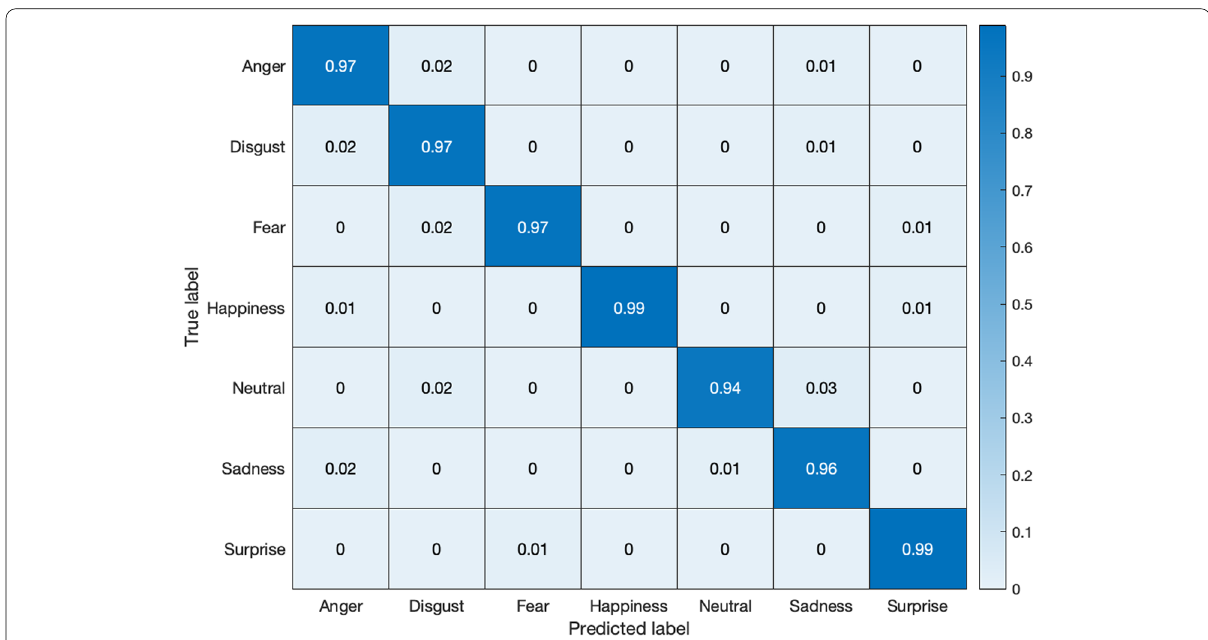
Fig. 14 Confusion matrix of facial expressions in MMI database